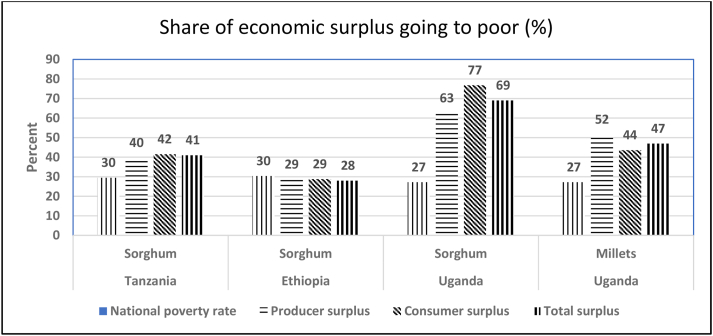
Potential impacts of R & D on poverty.Sources: Tanzania: Gierend et al. (2014b), p.64 Table 42; Ethiopia: Gierend et al. (2014c), p. 113 Table 73; Uganda: Gierend et al. (2014a), p. 72 Table 62.